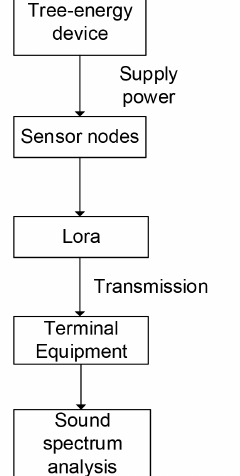
Figure 1. An overall flowchart of system.